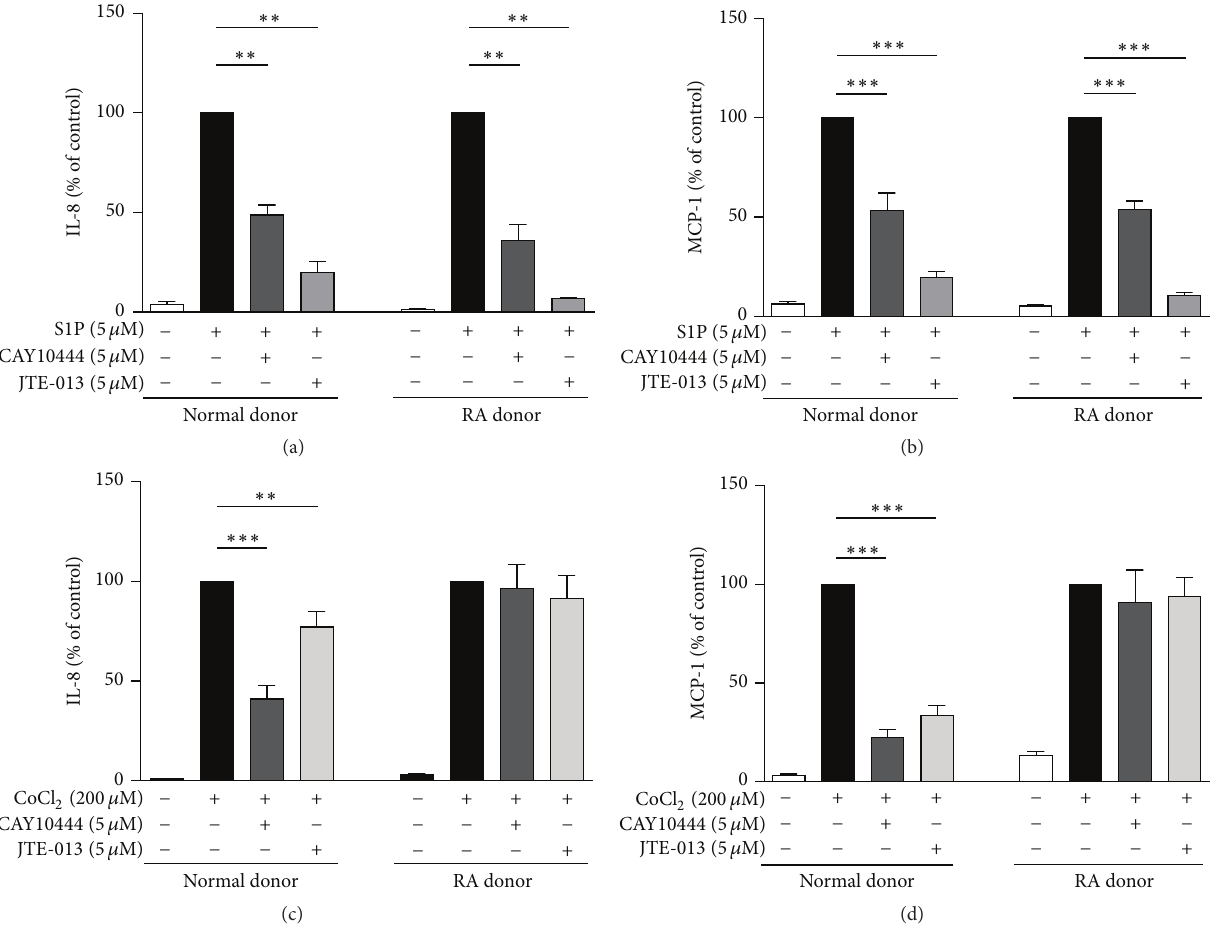
Figure 3: Differential involvement of S1P receptors in S1P- and CoCl 2 -mediated chemokine secretion by normal FLS and RAFLS. Human primary FLS from normal ( 𝑛 = 4 ) and RA ( 𝑛 = 4 ) donors were incubated with 5 𝜇 M S1P (a, b) or 200 𝜇 M CoCl 2 (c, d). Where indicated, cells were pretreated with S1P 3 antagonist CAY10444 (5 𝜇 M) or S1P 2 antagonist JTE-013 (5 𝜇 M) for 30 min before stimulation with S1P or CoCl 2 . The amounts of chemokines released in the supernatants were monitored after 24 h. Data are expressed as percentage of chemokine production induced by S1P (a, b) or CoCl 2 (c, d). The data are the means ± SE from four experiments (4 different donors) performed in triplicate (3 independent experiments). For statistical comparative analyses, the samples stimulated with S1P (a, b) or CoCl 2 (c, d) were compared to those stimulated in the presence of CAY10444 or JTE-013, respectively. ∗∗ 𝑝 < 0.01 ; ∗∗∗ 𝑝 < 0.001